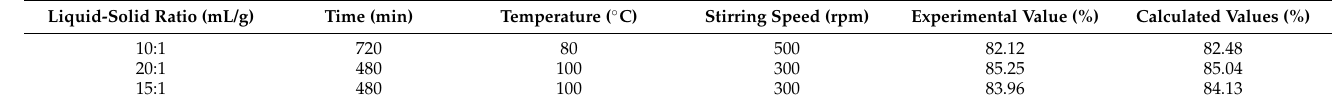
Table 5. Comparison of mental values and calculated values.